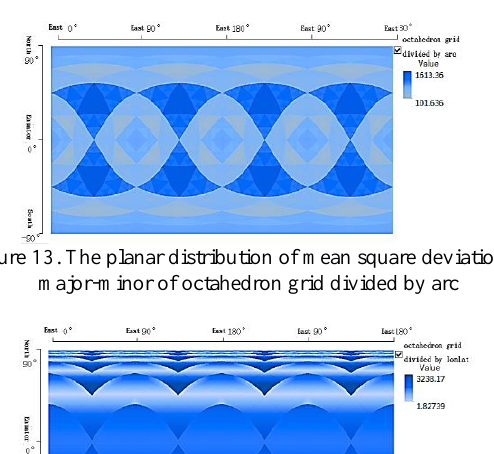
Figure 12. The planar distribution of mean square deviation of major-minor of icosahedron grid divided by arc